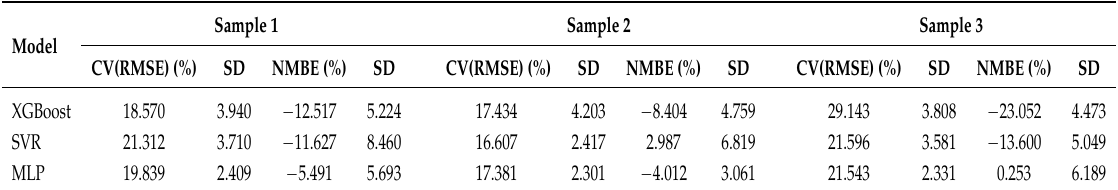
Table 2. Numerical results of the thermal demand predictions for all validation samples. The mean of the CV(RMSE) and the Normalized Mean Biased Error (NMBE) obtained through the 10 trials, besides the standard deviation (SD) of each of them, are presented.